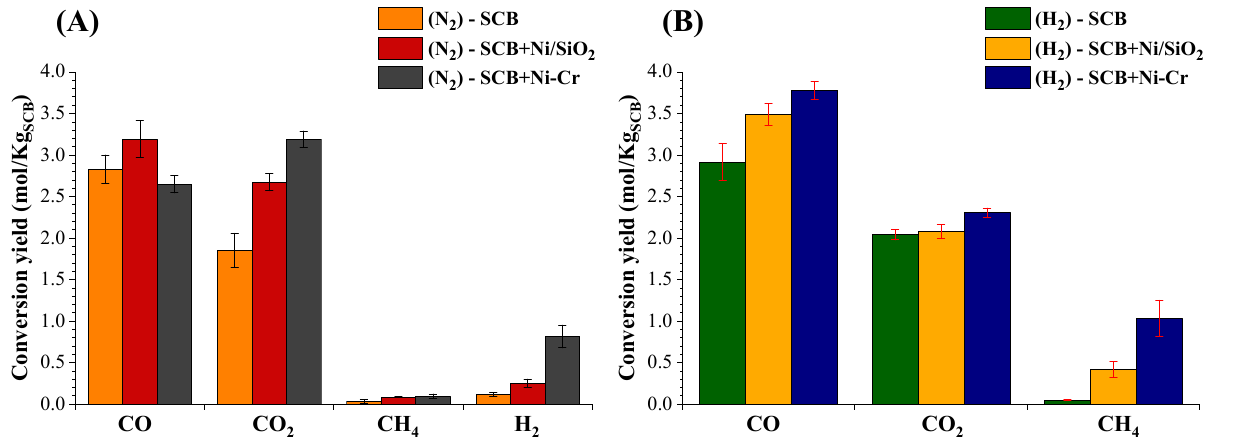
Figure 1. Composition of the gaseous products: ( A ) non-catalytic and catalytic pyrolysis and ( B ) non-catalytic and catalytic hydropyrolysis.